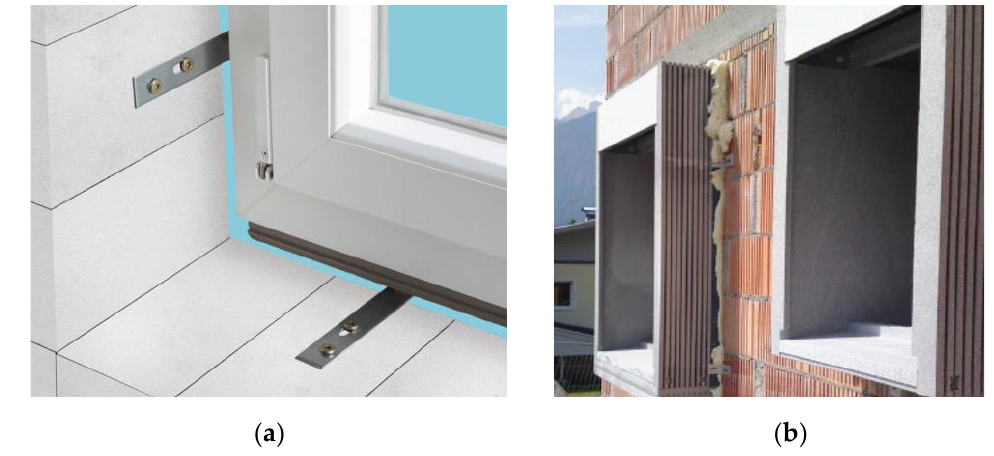
Figure 2. System of window installation in the insulation layer: ( a ) on anchor brackets [27]; ( b ) on chipboard frame [28].